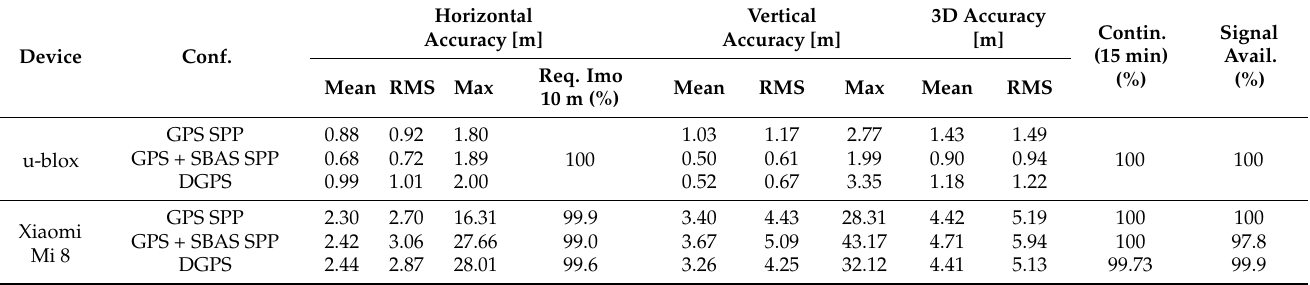
Table 3. Summary results of performance analysis conducted in terms of accuracy (using as figures of merit Root Mean Square (RMSE), mean and maximum errors) for both horizontal (H) and vertical (Up) components of position, tridimensional accuracy (using as figures of merit Root Mean Square (RMS) and mean errors), IMO parameter on absolute horizontal accuracy, availability and continuity (over 15 min) using data collected in kinematic mode by the u-blox receiver and the Xiaomi Mi 8